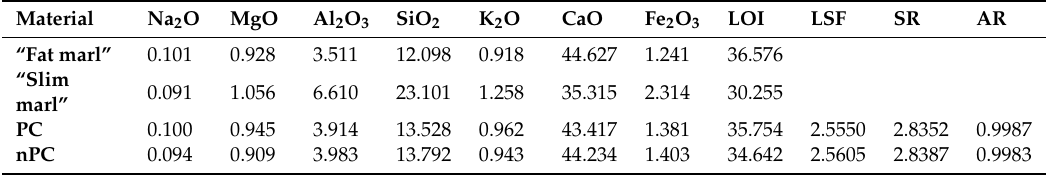
Table 1. Chemical composition and Loss on Ignition (LOI) (wt %) of marls and raw mixtures. PC is the standard Portland Clinker and nPC is the Portland Clinker produced by using 5 wt % of nano-Ca(OH) 2 in the raw mixture. The LSF (Lime Saturation Factor), SR (Silica Ratio), and AR (Alumina Ratio) parameters [4] are also